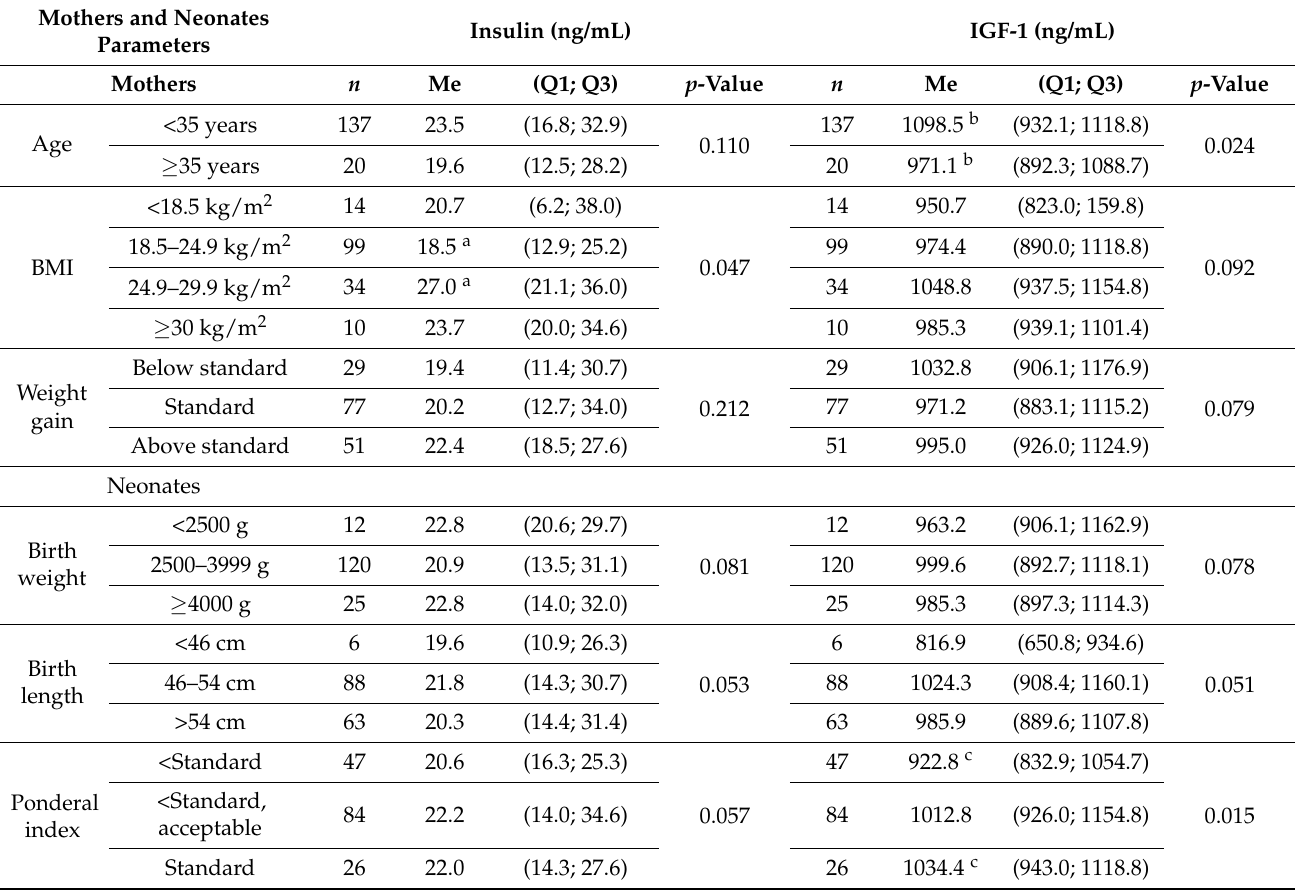
Table 4. Association of plasma insulin and IGF-1 concentration in mothers with age, BMI, weight gain during pregnancy, and anthropometric measures in offspring at birth ( n =